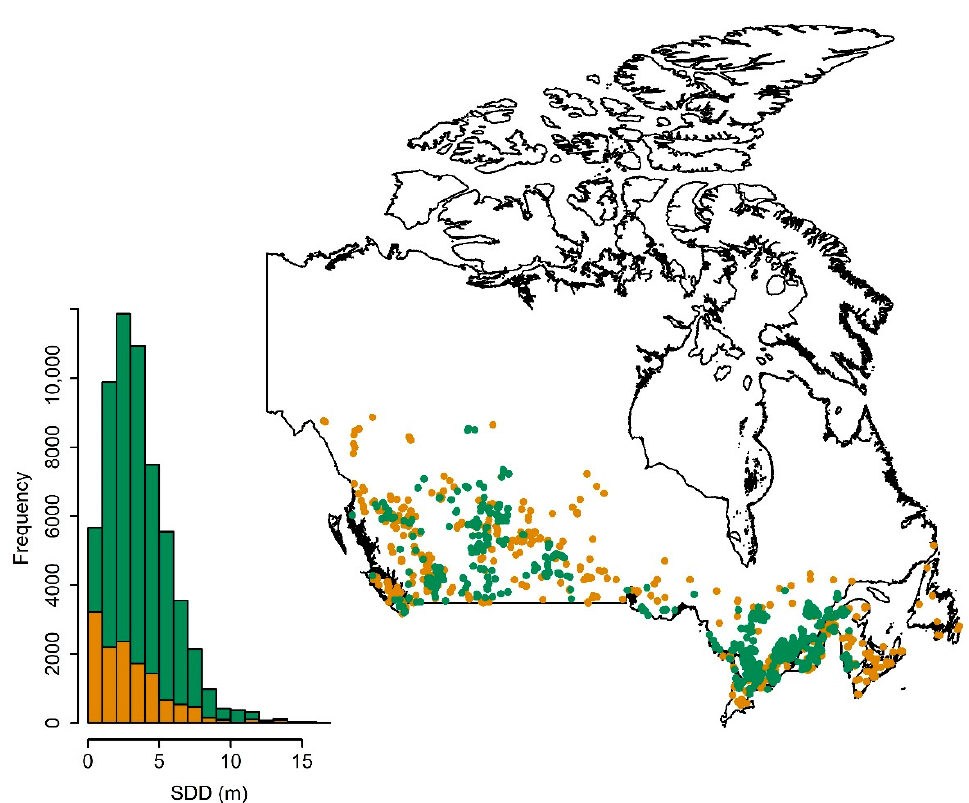
Figure 3. Calibration (green) and validation (orange) sampling station locations plotted on a map of Canada for the temporal window assessment. Also showing a histogram of the frequency of SDD values across the two datasets (calibration = green, validation = orange).